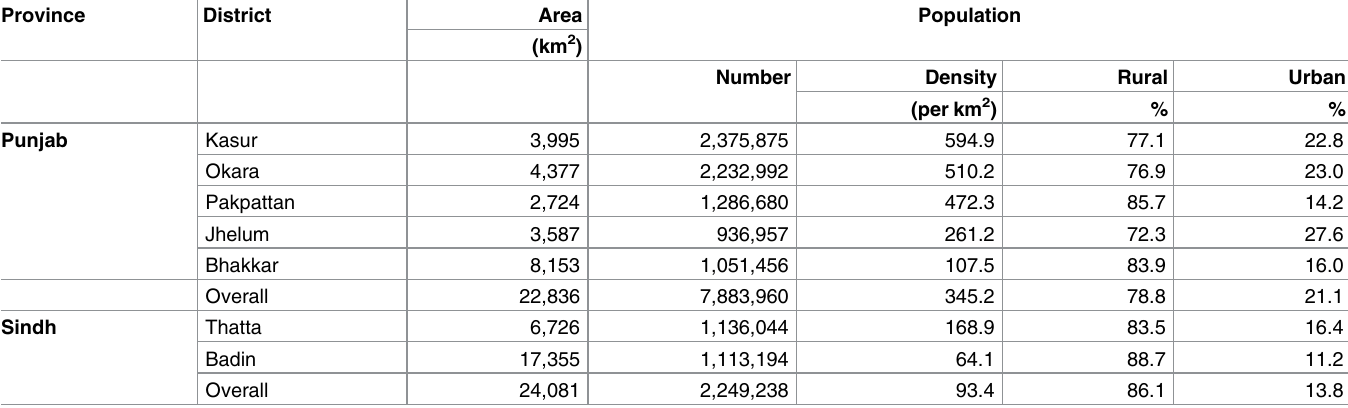
Table 1. Demographic characteristics of the study districts of Pakistan. Source: Pakistan Bureau of Statistics